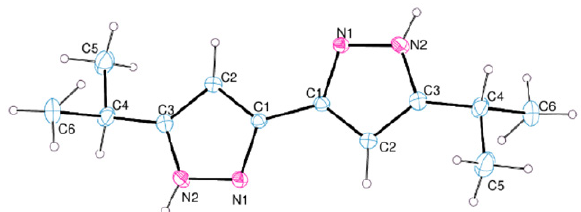
Fig. 3. The molecular unit of 5 with its inversion center in the mid- dle of the C1C1